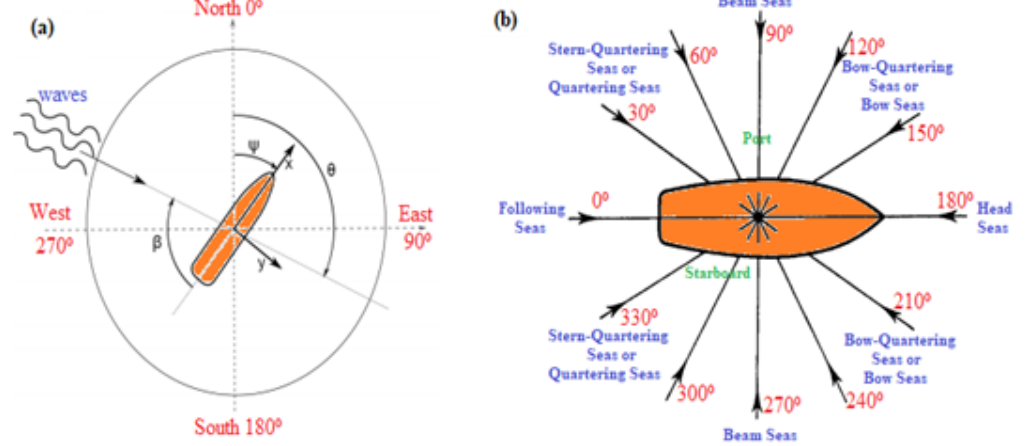
Figure 19. Definition of sea flow angles in approach direction relative to FPSO, showing ( a ) waves on FPSO and ( b ) the wave heading with other different types of seas defined.